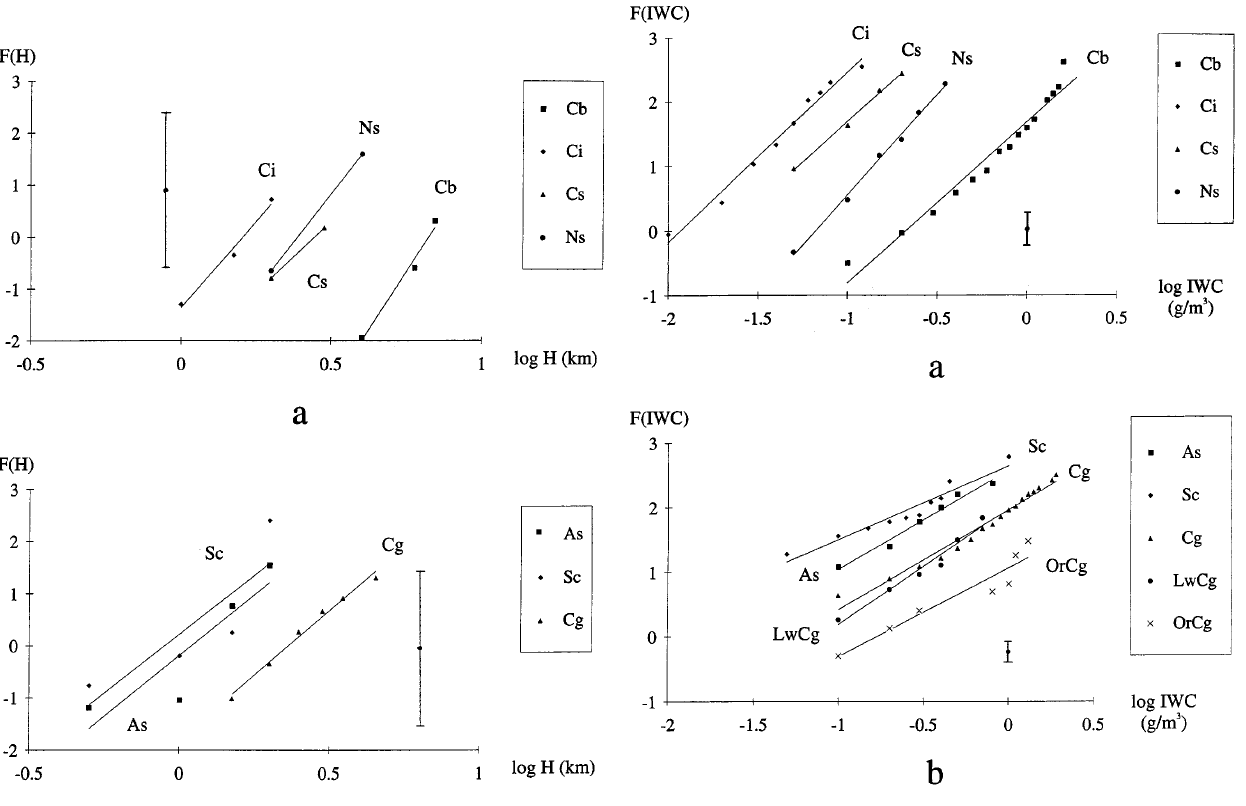
Fig. 2a, b. Cumulative frequency distributions of thickness ( H , in km) and log-normal fitting: a for types Cb, Ci, Cs, Ns; b for types As, Sc, Cg. Application of formula (16) with an accuracy of 20% on heights yields rather large errors of about (cid:6) 1 : 5 on distributions